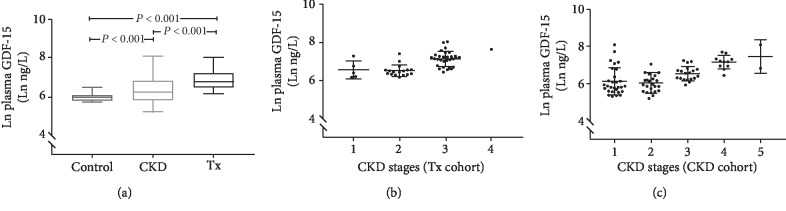
Comparison of plasma GDF-15 levels (mean ± SD) in the Tx cohort, CKD cohort, and healthy controls. Distribution of plasma GDF-15 values (mean ± SD) according to CKD stages in the Tx cohort (b) and CKD cohort (c). Shown in natural logarithmic (Ln) transformation due to skewed distribution.